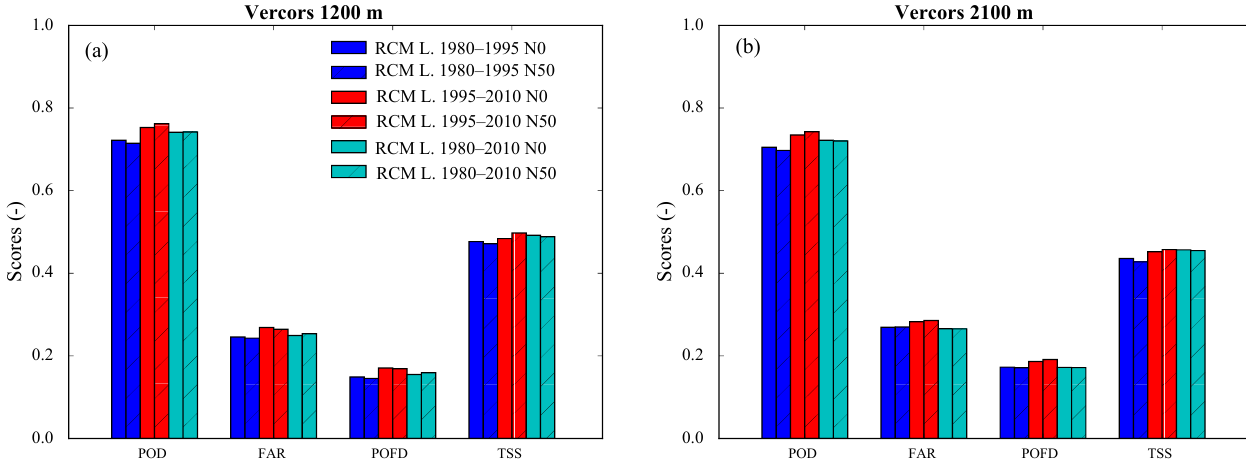
Figure 16. Scores for the detection of precipitation events in each adjusted RCM simulation compared to the SAFRAN reanalysis over the evaluation period for the Vercors massif at (a) 1200 and (b) 2100ma . s . l . POD is the probability of detection, FAR is the false alarm rate, POFD is the probability of false detection and TSS is the true skill